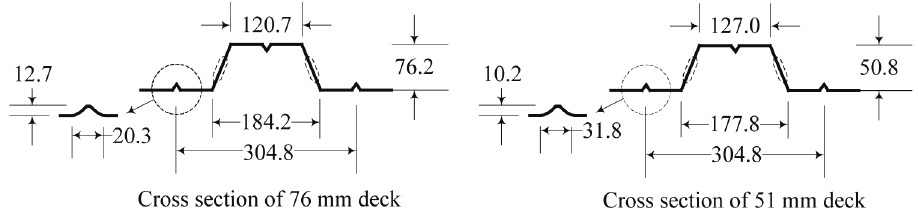
Fig. 6. Deck’s cross sections and dimensionsin millimeters (Abdullah, Easterling 2007,